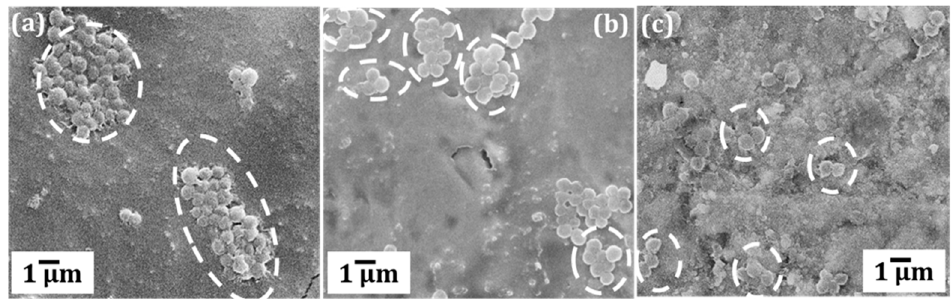
Figure 4. SEM micrographs of S. aureus colonies formed after 24 h over ( a ) pristine ( b ) cold rolled and ( c ) cryo-rolled copper coupons.